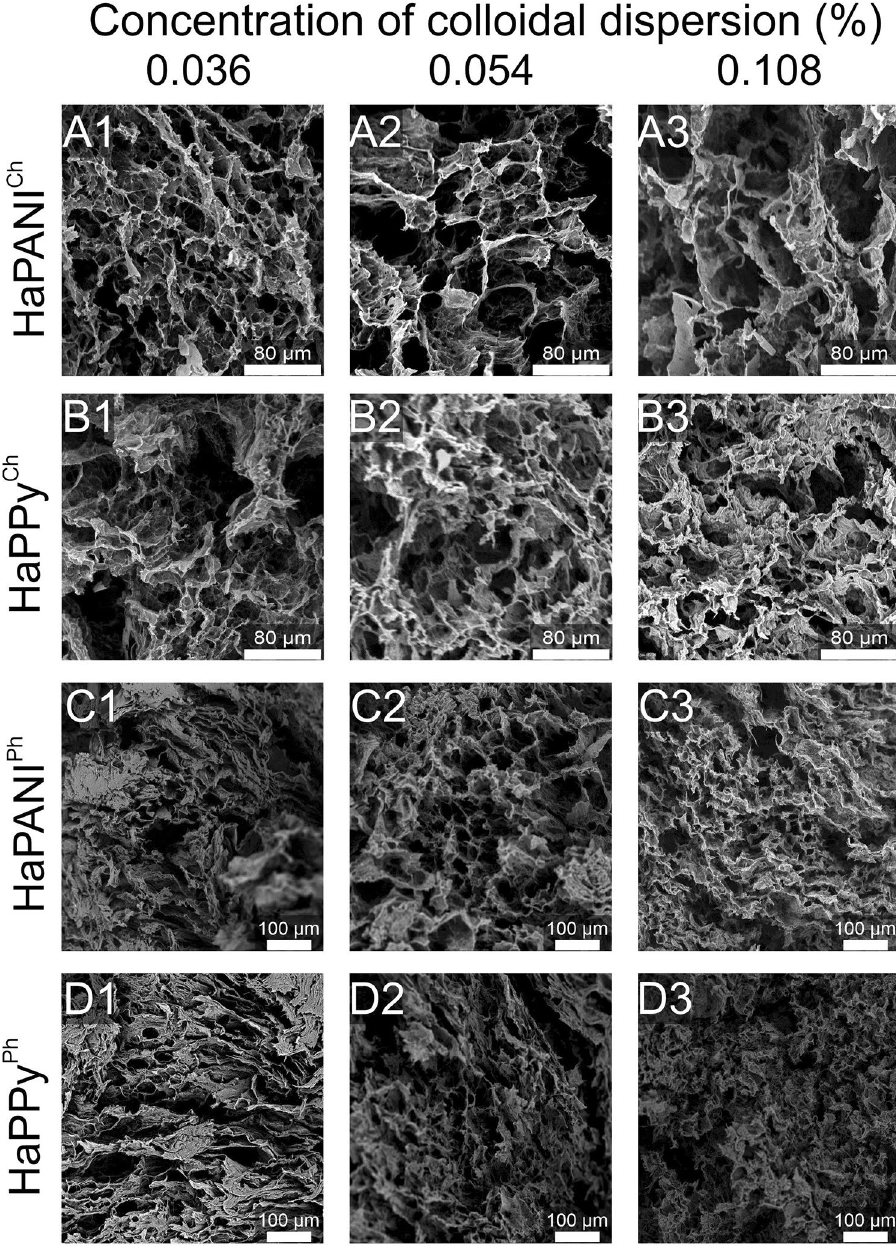
Figure 4. SEM photomicrographs of lyophilized HaPANI Ch ( A ), HaPPy Ch ( B ), HaPANI Ph ( C ) and HaPPy Ph ( D ) containing colloid concentrations of 0.036 (1), 0.054 (2), or 0.108(3)